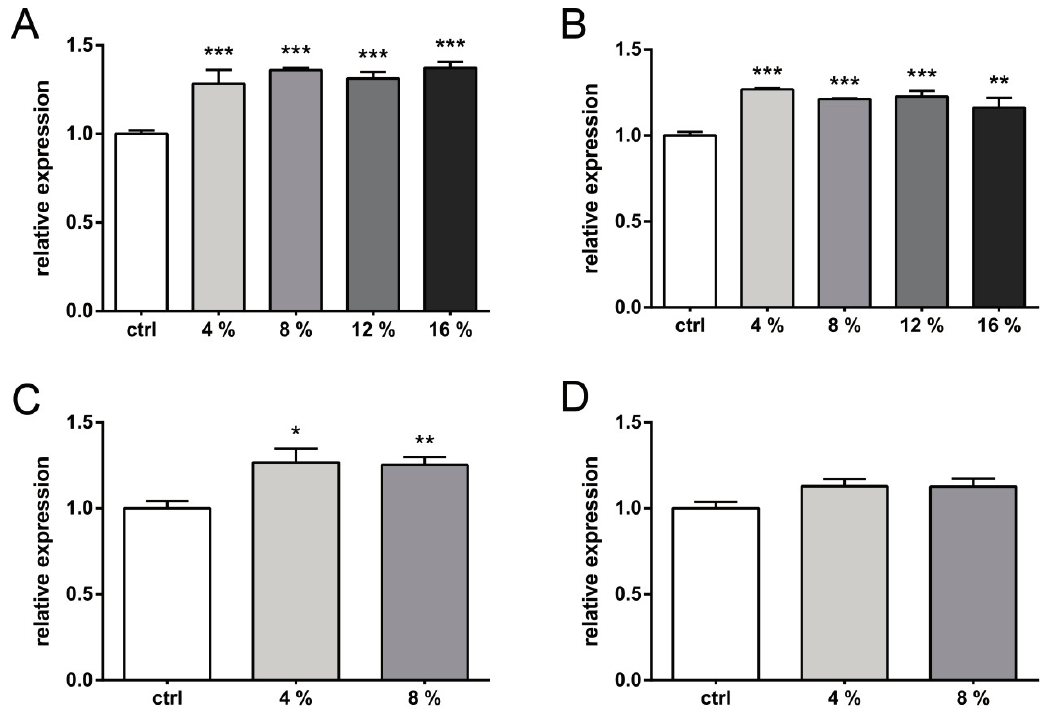
Figure 2. Strain-dependent VEGF expression in primary chondrocytes. Cells were strained for 12 h with cyclic waveforms and a variety of relative strains. VEGF expression was analyzed directly after straining ( t ) ( A and C , respectively) or 24 h post stretching ( B and D , 0 respectively). The figures show data obtained with square waveforms at 0.5 Hz ( A , B ) and 1.0 Hz ( C , D ). Relative percentages of stretching are indicated ( i.e. , 4%, 8%, 12% or 16%, respectively). Unstrained controls (ctrl) were used to normalize data (set to 1). * , **